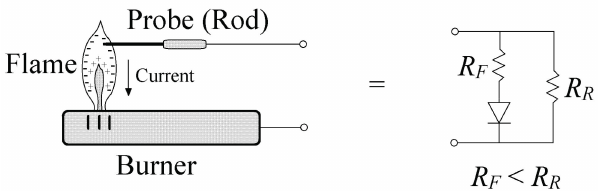
Figure 1. The equivalent circuit of a flame ionization measurement system. R F and R R are the forward and reverse flame resistances, respectively. The forward resistance is always lower than the reverse resistance, no matter the AC voltage applied to the